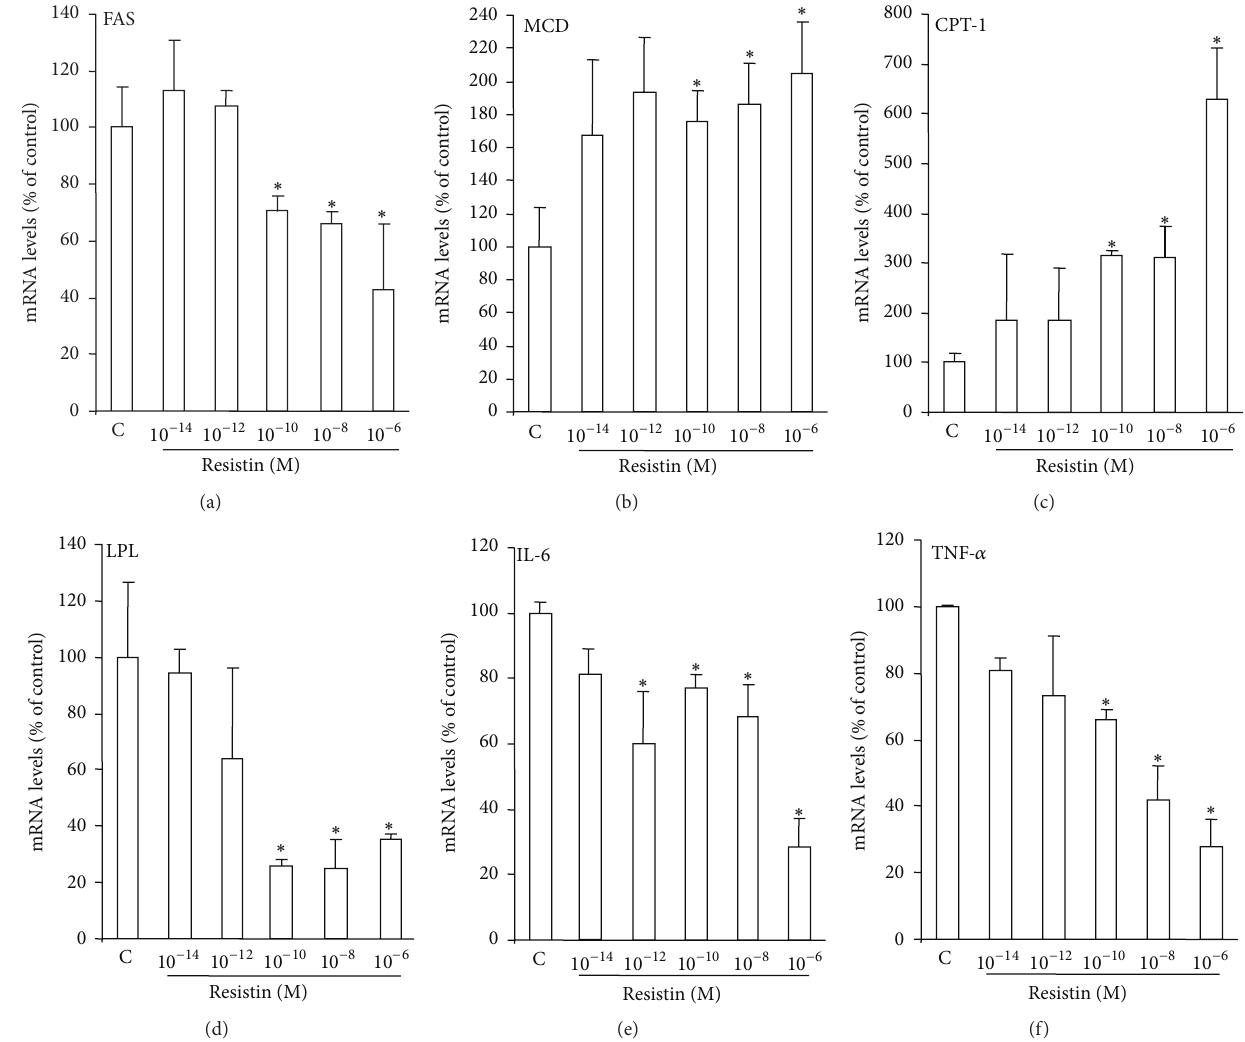
Figure 3: Effect of resistin on mRNA levels of lipid metabolism enzymes and proinflammatory cytokines in vitro . Mean + SEM mRNA levels of ACC 𝛼 , CPT-1, FAS, LPL, MCD, SCD-1, SREBP, IL-6, and TNF-alpha. After 3 days of culture, dispersed rat pituitary cells were incubated in medium alone (C, Control) or in the presence of resistin (10 −14 –10 −6 M) for 4h. After culture, cells were harvested, and receptor mRNA levels were determined by real-time RT-PCR. Enzymes band intensities were determined and adjusted by the signal intensity for HPRT. The averaged results were then calculated and expressed as a percentage of vehicle-treated control levels (100%). Data are the mean ( ± SEM) of three separate experiments. At least three replicate wells were evaluated per treatment in each experiment. ∗ 𝑃 < 0, 05 versus corresponding